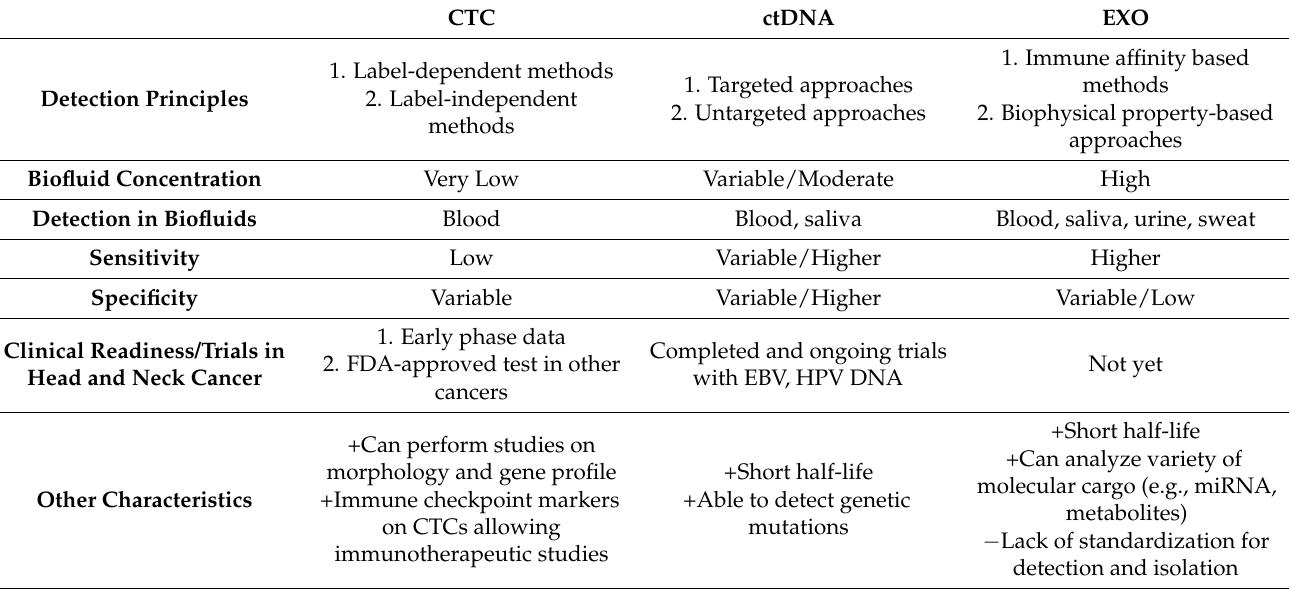
Table 4. Current strengths and limitations of major liquid biopsy